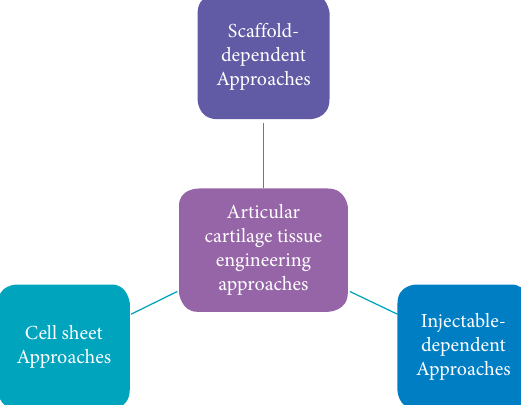
Figure 1: Articular cartilage tissue engineering